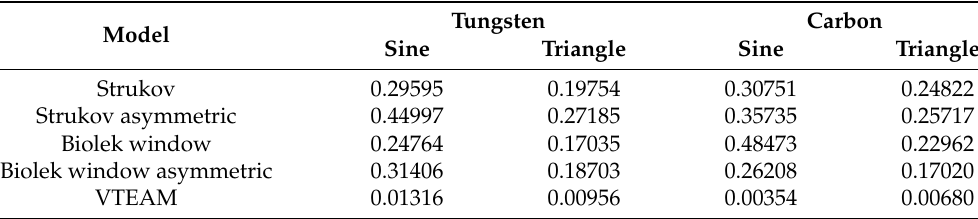
Table 5. Average cost function values for all tested models grouped by the doping agent and the wave shape of the excitation